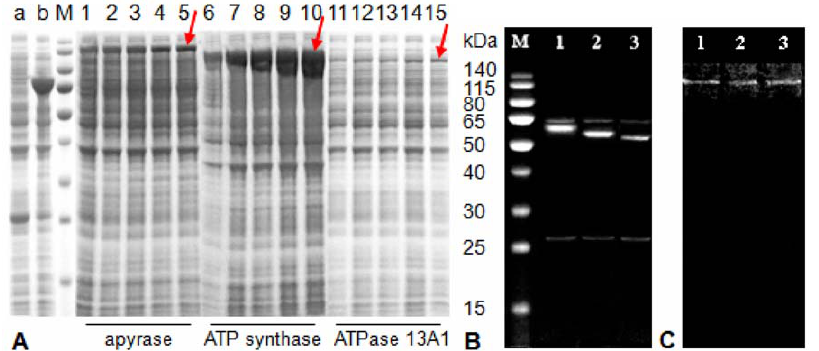
Figure 3. SDS-PAGE analyses of protein expression and purification. A , expression time-courses of the fusion proteins in E. coli . Lane a, control 1, total cellular proteins from E. coli Rosetta 2 (DE3) after being induced by 1.0 mM isopropyl b -D-1-thiogalactopyranoside (IPTG) for 2.5 h. Lane b, control 2, expression of empty pET-43.1b( + ) vector protein after being induced by 1.0 mM IPTG for 2.5 h. Lane 1–5, 6–10 and 11–15 show the expressions of fusion apyrase, ATP synthase and ATPase 13A1 after being induced by 1.0 mM IPTG for 2, 3, 4, 5 and 6 h, respectively. B , SDS-PAGE analysis of purified apyrase (lane 1), ATP synthase (lane 2) and ATPase 13A1 (lane 3) from E. coli . Lane M, protein molecular weight markers. C , native PAGE analysis of purified apyrase (lane 1), ATP synthase (lane 2) and ATPase 13A1 (lane 3). Arrows represent the locations of target proteins.